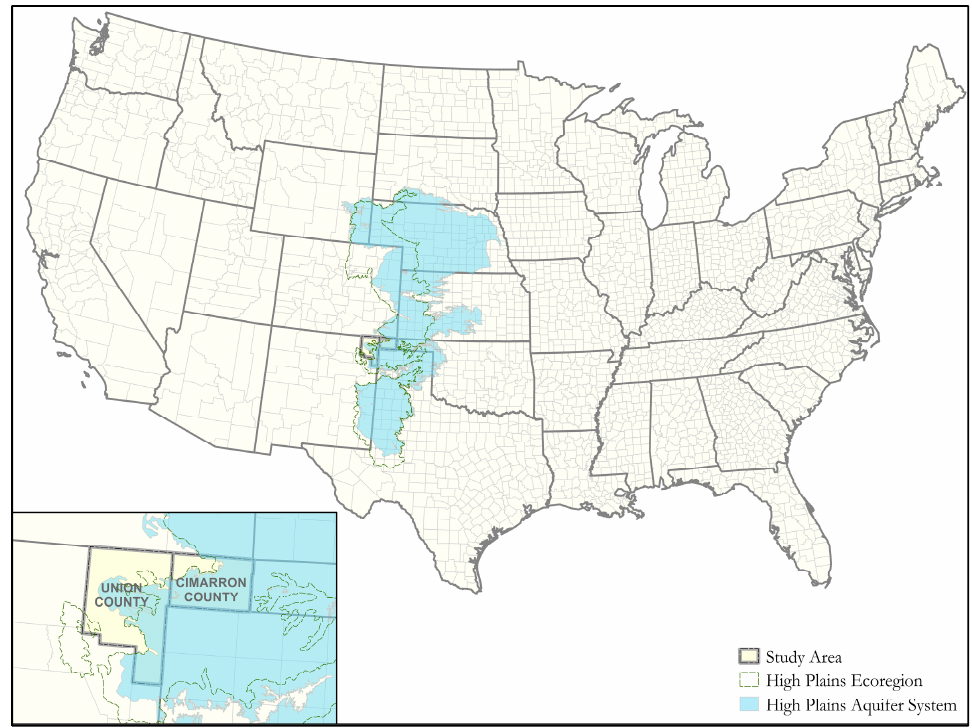
Figure 1. The High Plains Ecoregion and High Plains Aquifer System in relationship to the bi-county focal area of the study (Source: Adapted from USGS High Plains Water-Level Monitoring Study, Environmental Protection Agency (EPA) Ecoregions of the Continental U.S. and U.S. Census